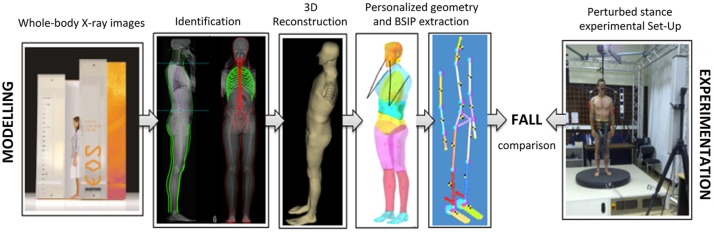
Kinematic comparison of a real vs. a theoretical fall in human subjects (experimental data) and their personalized mechanical models (simulation data), respectively.